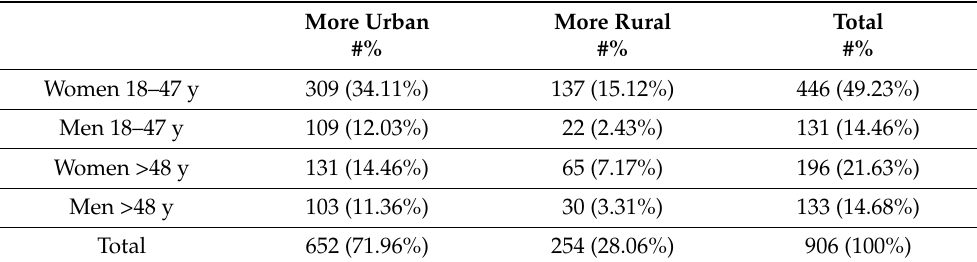
Table 6. Distribution of the sample according to age groups and gender by place of residence (number, percent (1) ).